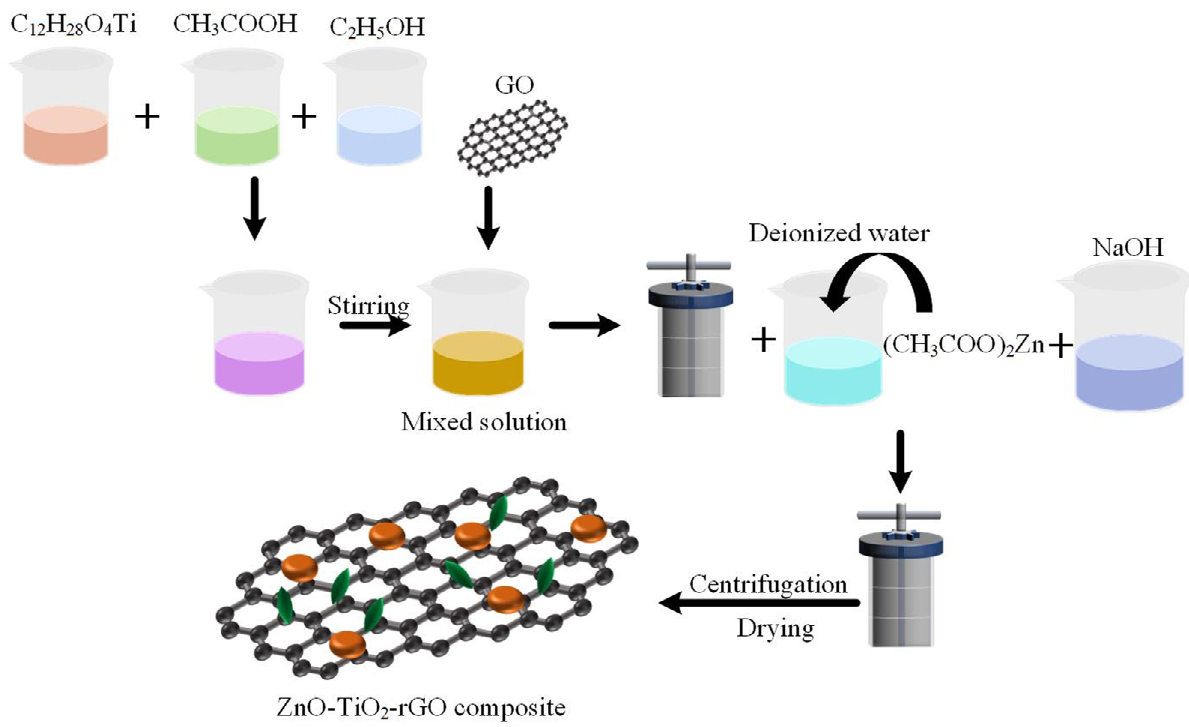
Figure 1. Schematic diagram of the synthesis of ZnO-TiO 2 -rGO nanomaterials.